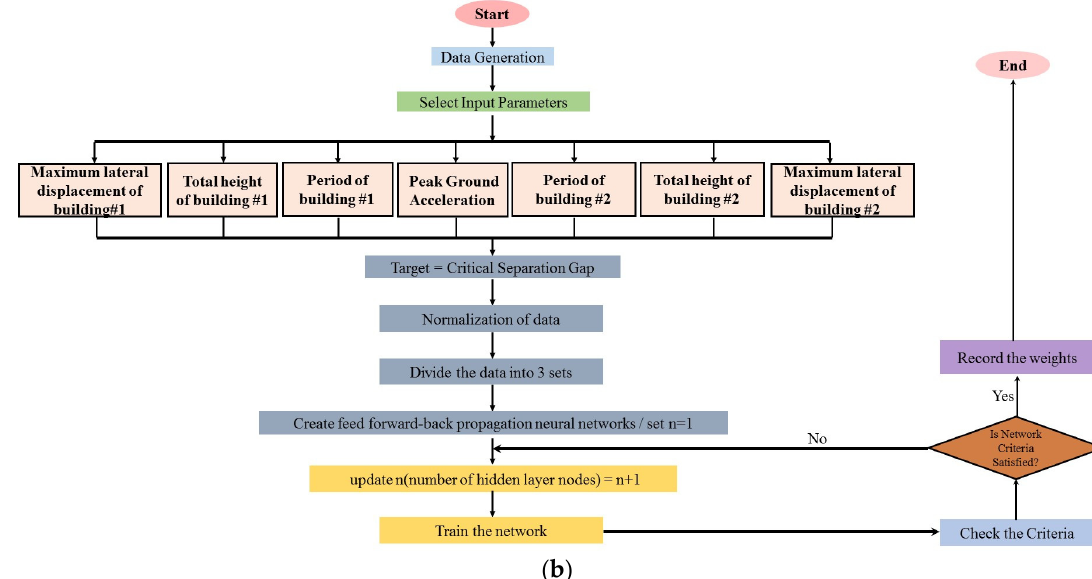
Figure 1. ( a ) Schematic architecture of the artificial neural network (ANN) model, ( b ) flowchart of the ANN algorithm.